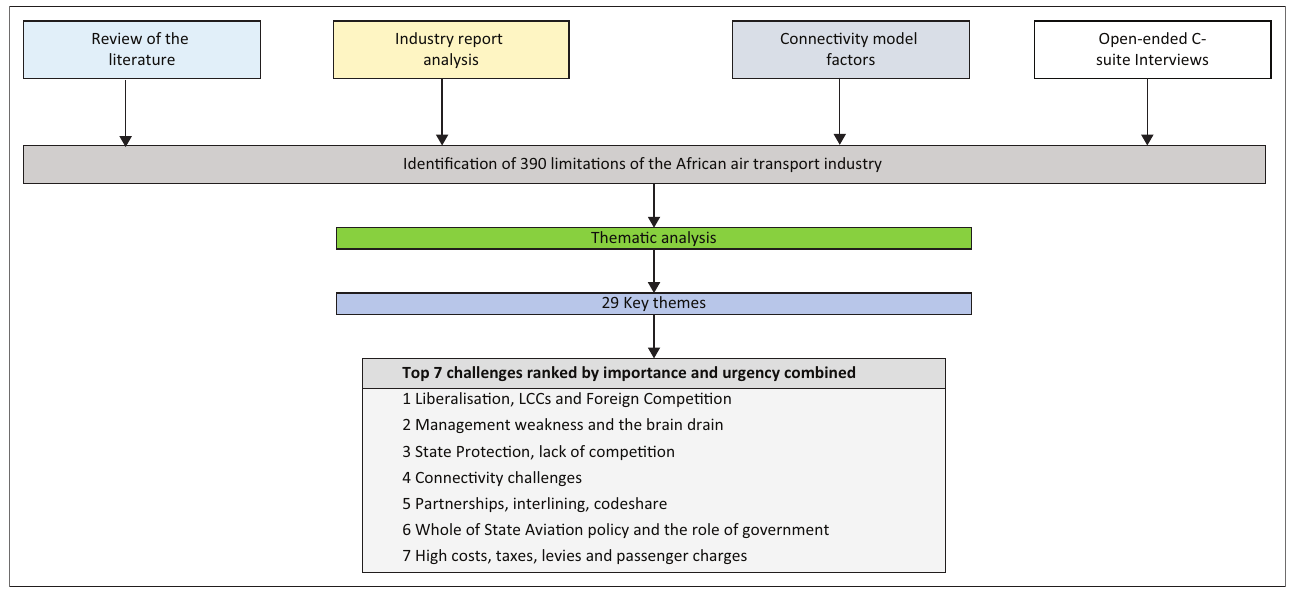
FIGURE 2: The process used to derive the identified seven